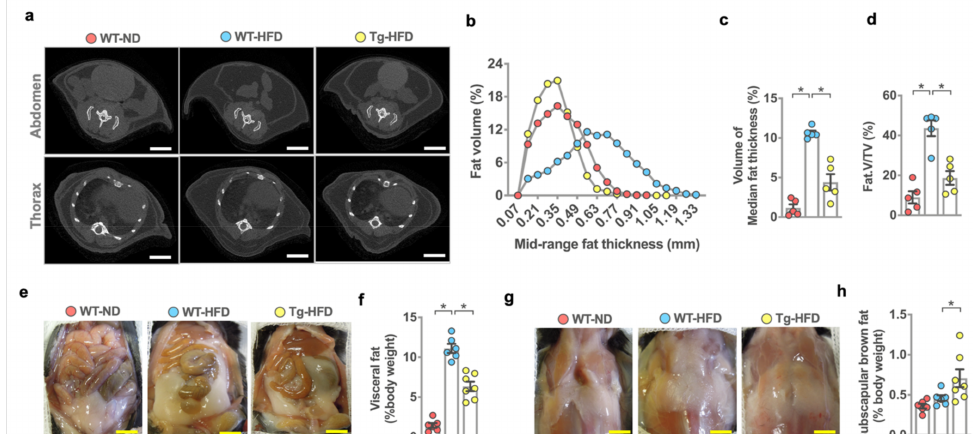
Figure 2. Analysis of adipose tissue of wild-type and miR-29aTg mice upon standard rodent chow (ND) and high-fat diet (HFD) feeding. µ CT images of the abdomen fat and subcutaneous fat in the thorax compartment ( a ); scale bar, 15 mm. miR-29a reversed HFD-induced overall fat thickness ( b ), median fat thickness ( c ) and Fat.V/TV ( d ). Investigations (mean ± S.E.) are calculated from 5 mice. Images of visceral adipose tissue ( e ); scale bar, 18 mm. miR-29a attenuated HFD-induced visceral fat weight ( f ). Images of subscapular brown fat tissue ( g ), scale bar; 18 mm. HFD-fed miR-29a mice showed high subscapular brown fat mass ( h ). Mean ± S.E. is calculated from 6–7 mice. * p < 0.05 upon ANOVA test and Bonferroni post hoc test. ND, standard rodent chow; HFD, high-fat diet.